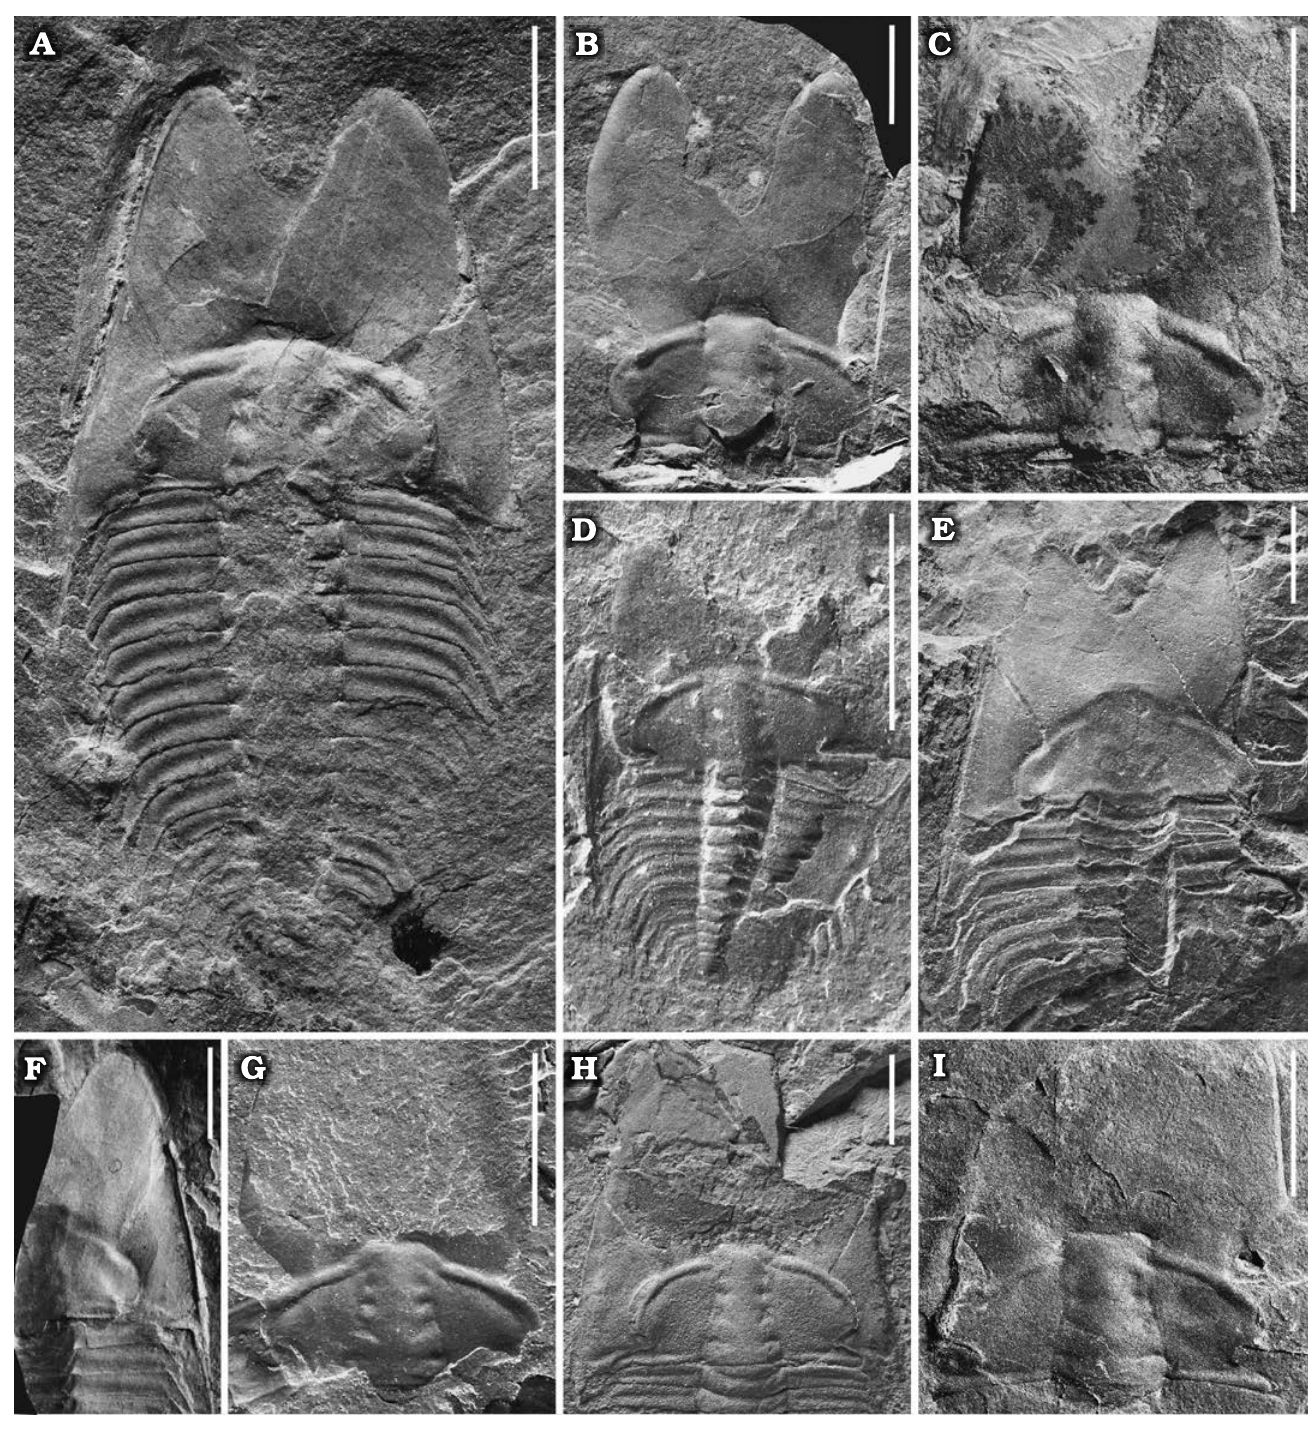
Fig. 3. A ptychoparioid trilobite Phantaspis auritus gen. et sp. nov. from the middle Cambrian (Miaolingian, Wuliuan) Mantou Formation, Longgang section, Shandong Province, North China. A . NIGPAS 172104 (holotype), nearly complete exoskeleton. B . NIGPAS 172105 (paratype), nearly complete cranidium. C . NIGPAS 172106 (paratype), external mould of a nearly complete cranidium. D . NIGPAS 172107 (paratype), external mould of a nearly complete, holaspid-stage exoskeleton. E . NIGPAS 172108 (paratype), external mould of a nearly complete cephalon. F . NIGPAS 172109 (paratype), internal mould of specimen in E. G – I . NIGPAS 172111, 172110, 172112, cranidia. Scale bars 5